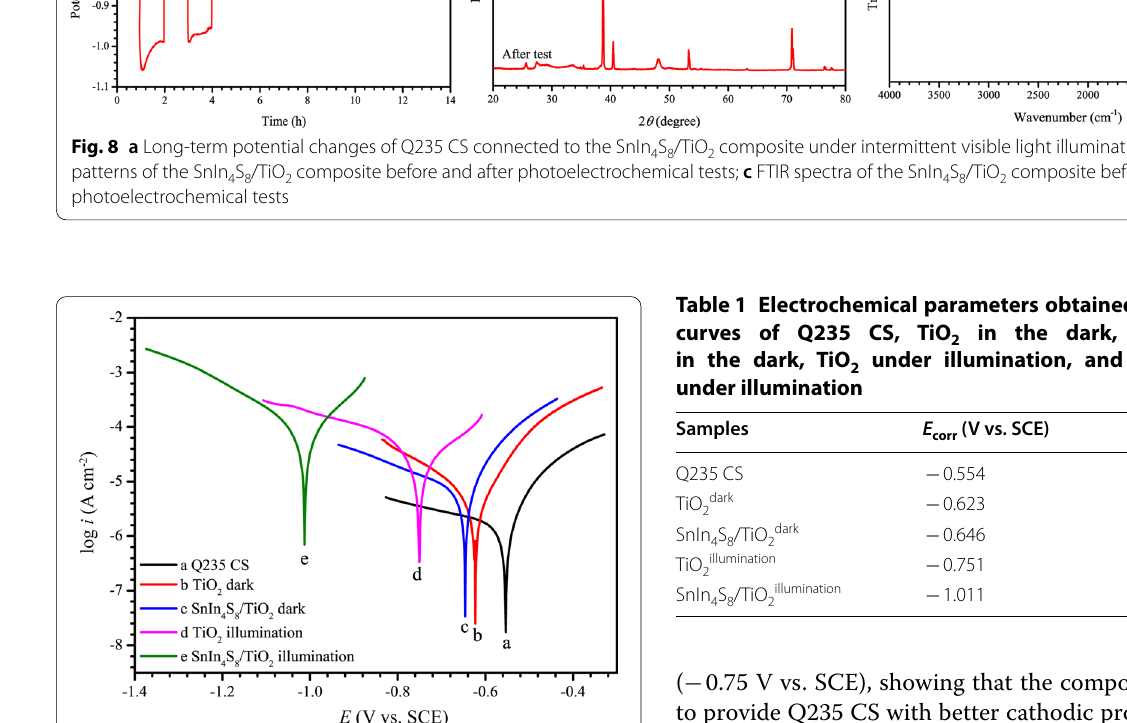
Fig. 9 Tafel curves of Q235 CS in 3.5% NaCl solution under different conditions, a bare Q235 CS, b Q235 CS coupled to TiO 2 NTs film in the dark, c Q235 CS coupled to SnIn 4 S 8 /TiO 2 composite film in the dark, d Q235 CS coupled to TiO 2 NTs film under visible light irradiation, and e Q235 CS coupled to SnIn 4 S 8 /TiO 2 composite film under visible light irradiation